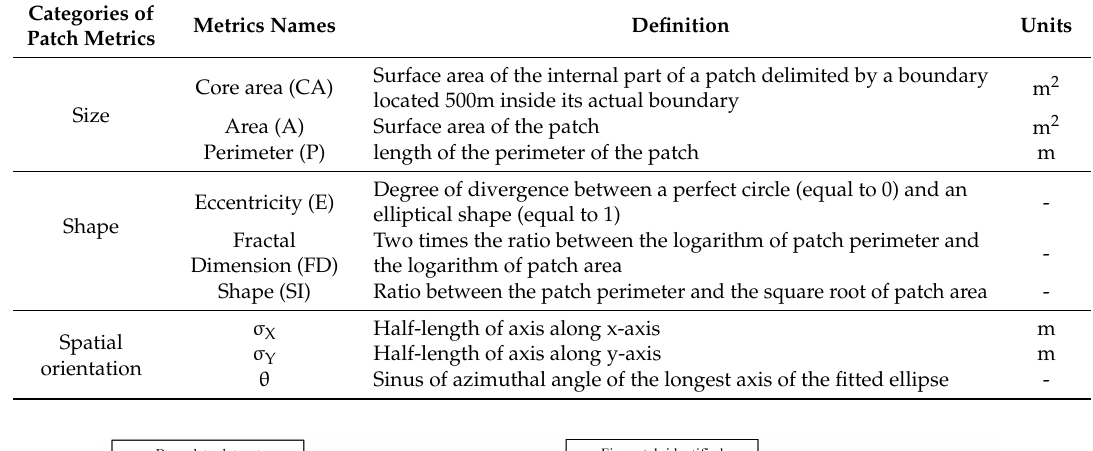
Table 2. Description of patch metrics for burn individual patches in each category.